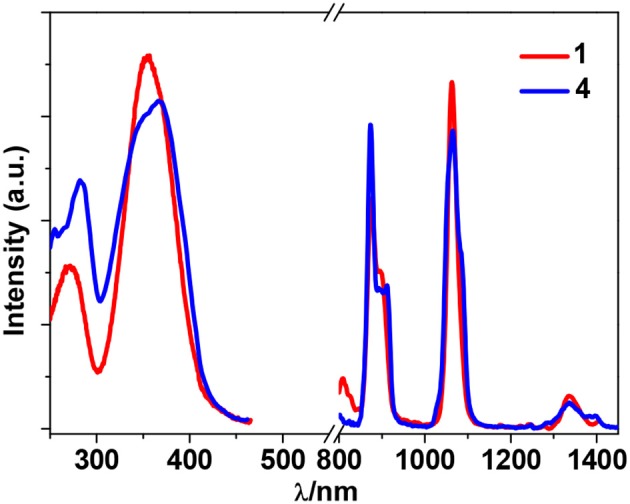
Excitation and emission spectra for 1 and 4 in CH3CN.